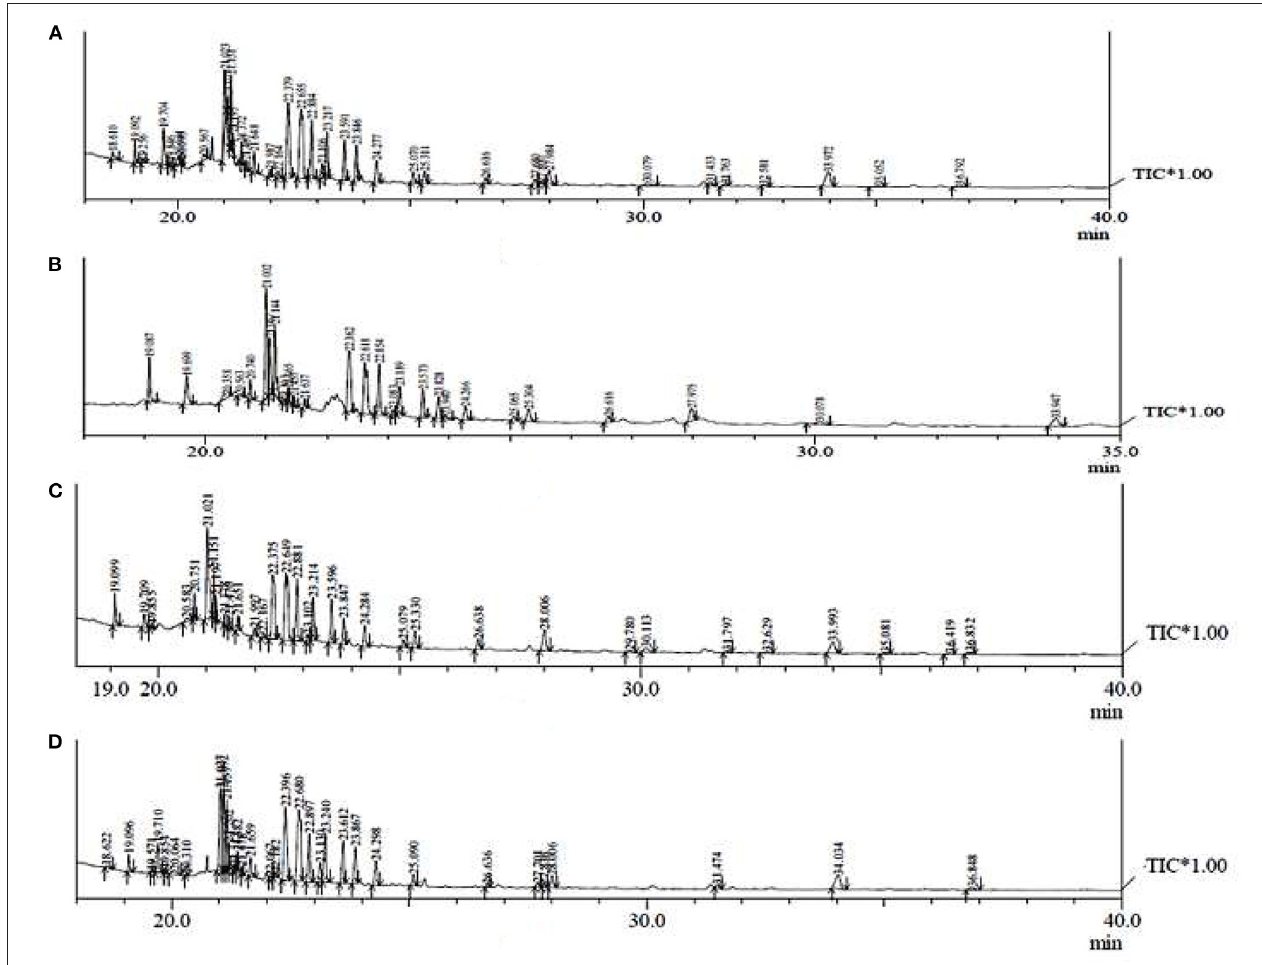
FIGURE 7 | GC-MS chromatogram of different extracts (A) MCP (B) SXCP (C) OMCP (D)